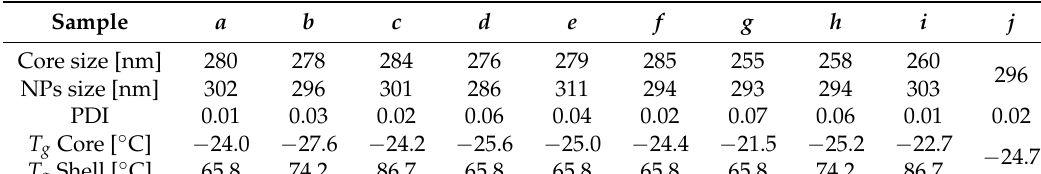
Table 1. Final size, PDI (polydispersity index) and glass transition temperature ( T g ) of the different polymer particles.